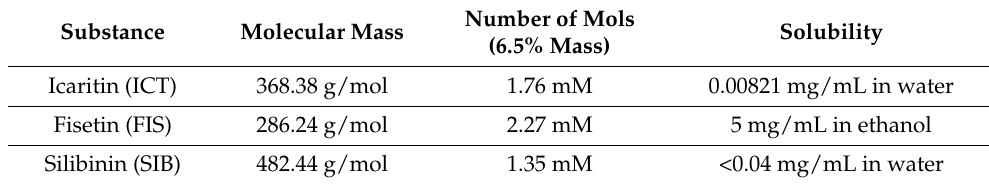
Table 1. Physical and chemical properties of flavonoids used in this study.